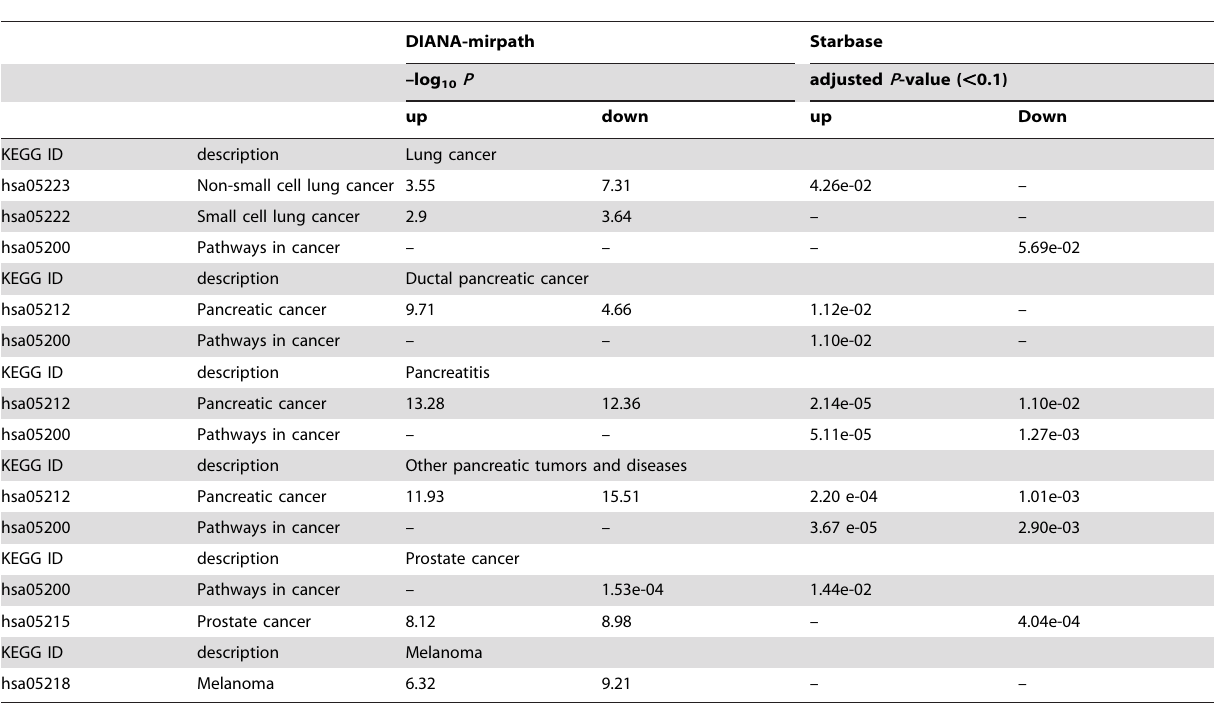
Table 5. Cancer-specific KEGG pathways enriched in miRNA target